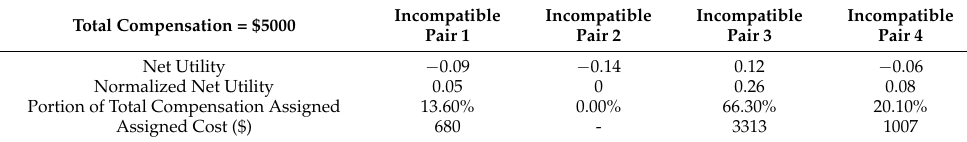
Table 4. Results of cost-apportionment process in scenario 1.